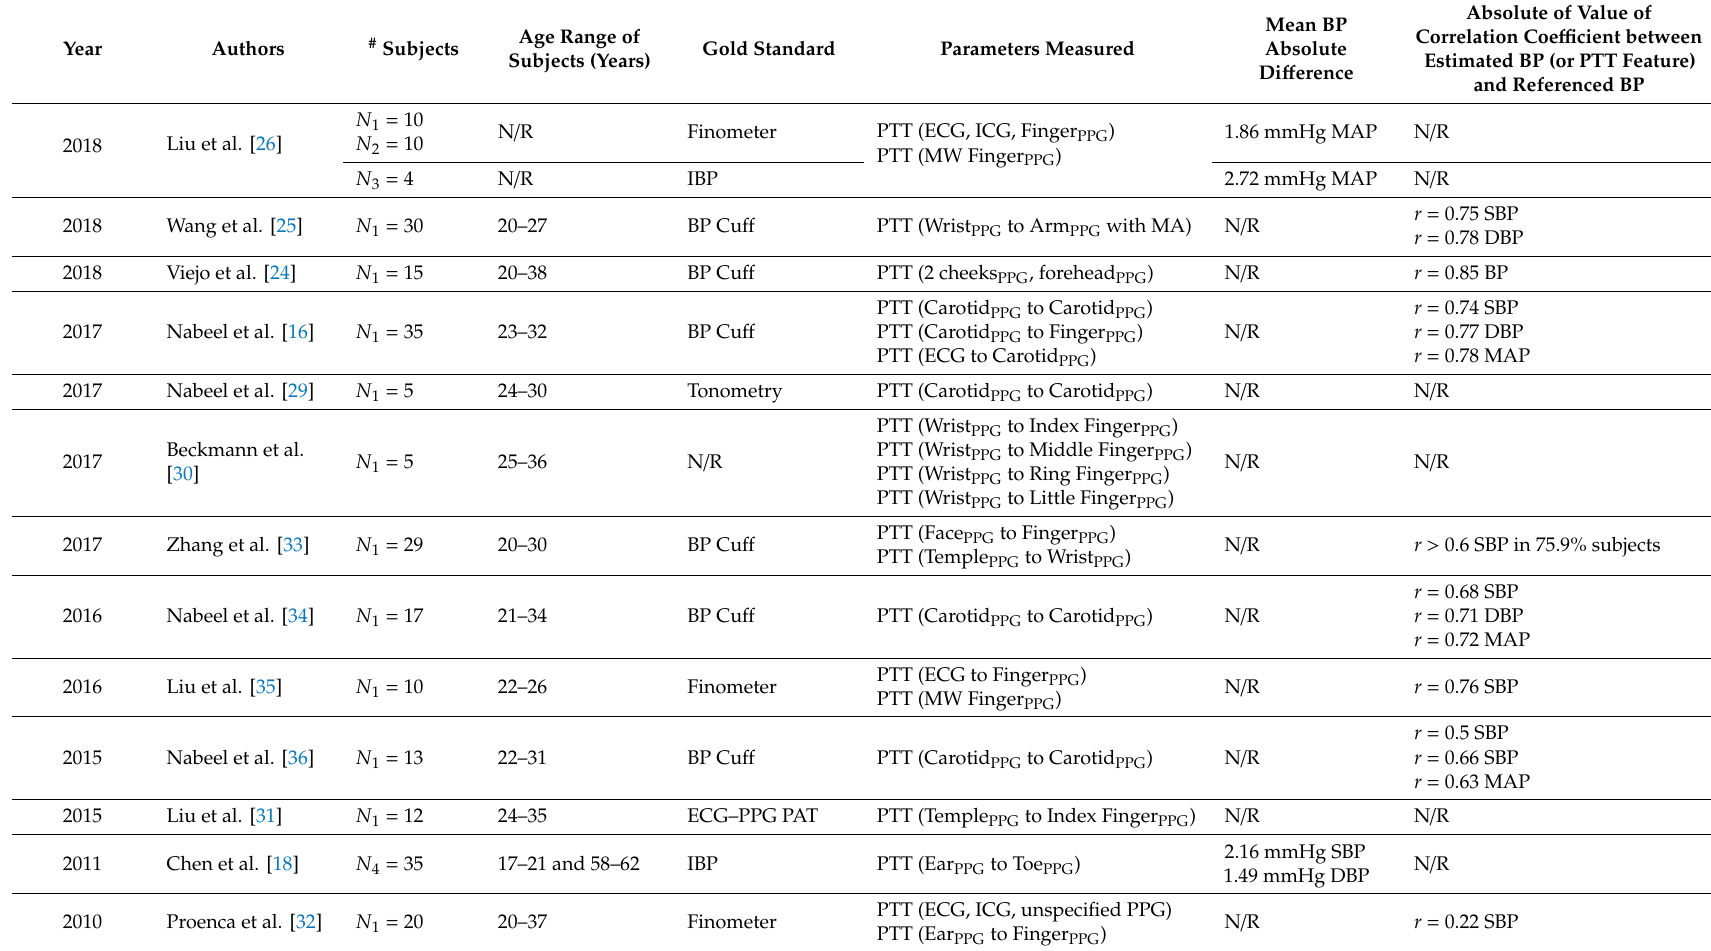
Table 1. Summary of findings of all papers included in this